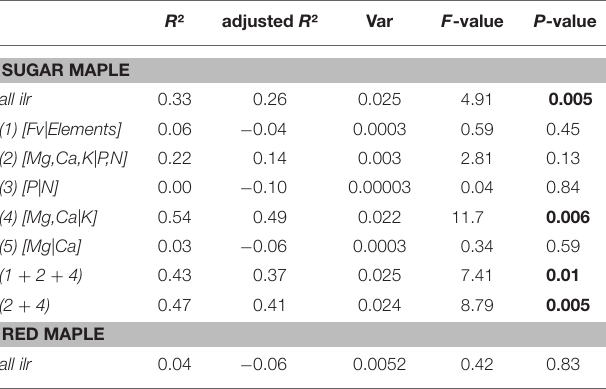
TABLE 5 | Foliar ilr balances that were computed based on nutrient concentrations found in the literature for healthy and declining sugar maple